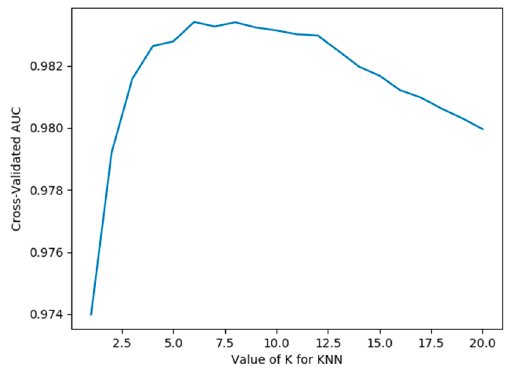
Figure 8. Influence of different k values on the detection effect.